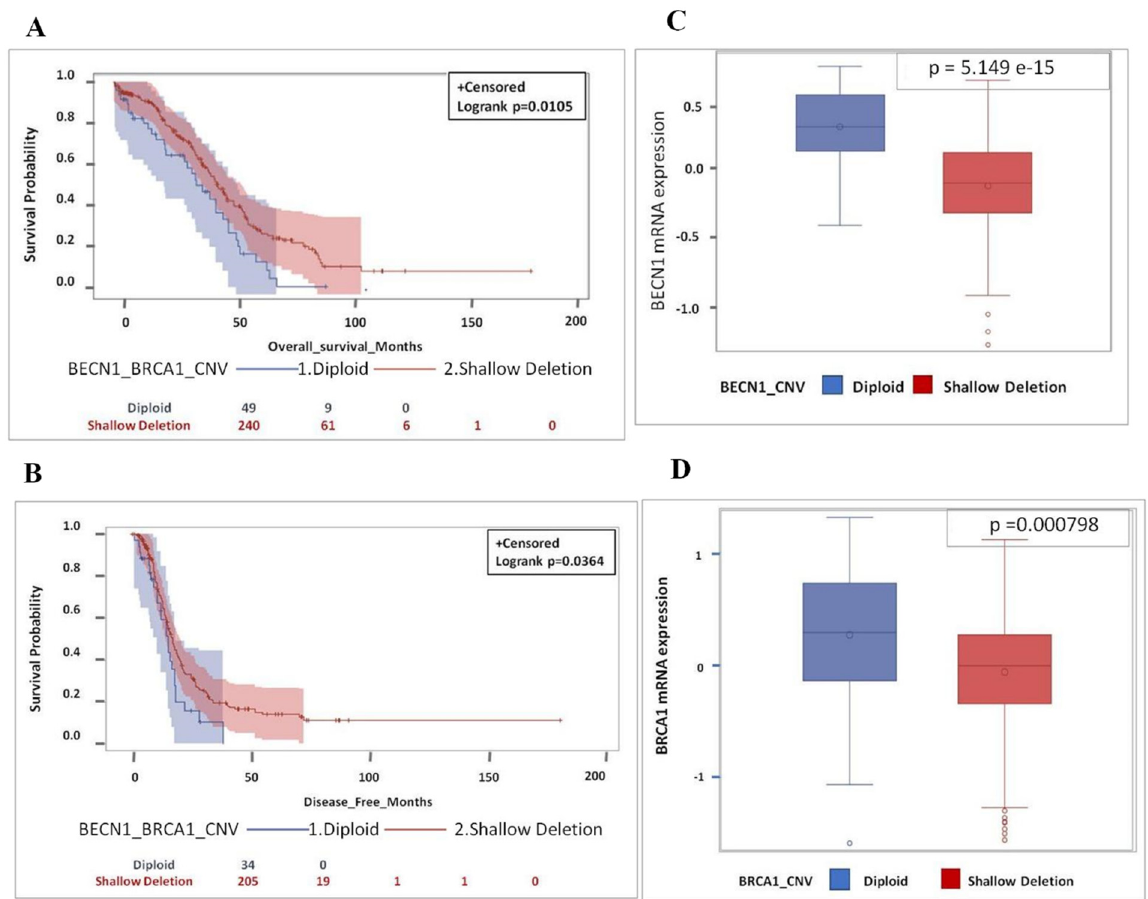
Figure 4. Shallow deletion of BECN1 and BRCA1 with low mRNA expression is associated with better overall and disease- free survival. ( A ) Overall survival for HGSOC patients according to BECN1 and BRCA1 CNV. ( B ) Disease-free survival for HGSOC patients according to BECN1 and BRCA1 CNV. ( C ) Box-plot showing the distribution of BECN1 expression according to CNV. ( D ) Box-plot showing the distribution of BRCA1 expression according to CNV. (Note that for OS data were not available for 1 patient (diploid group - 1 pt: 49 pt’s; diploid group total n =50 pt’s) while for DFS data were missing for 51 patients (diploid group - 16 pt’s: 34 pt’s + shallow deletion group - 35 pt’s: 205 pt’s; total n =290 pt’s), respectively).